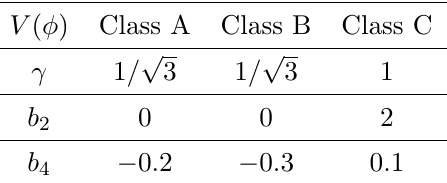
Table 1 . Parameters for three classes of used